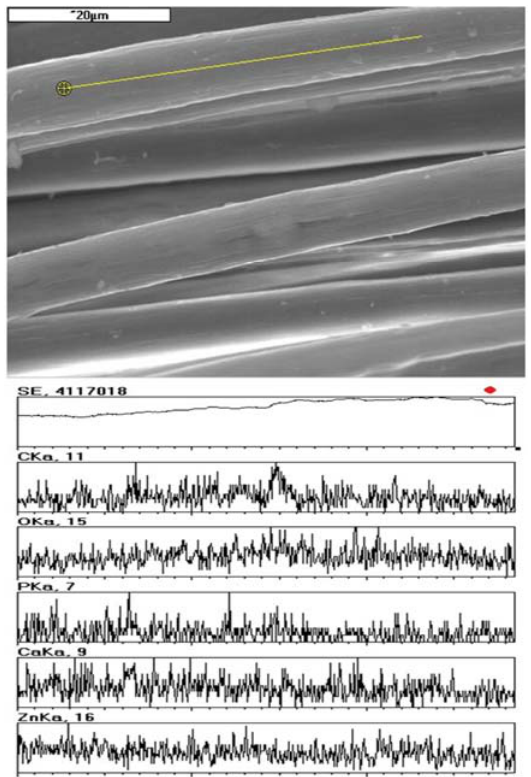
Figure 3. SEM+EDS analysis of zinc alginate fibres containing